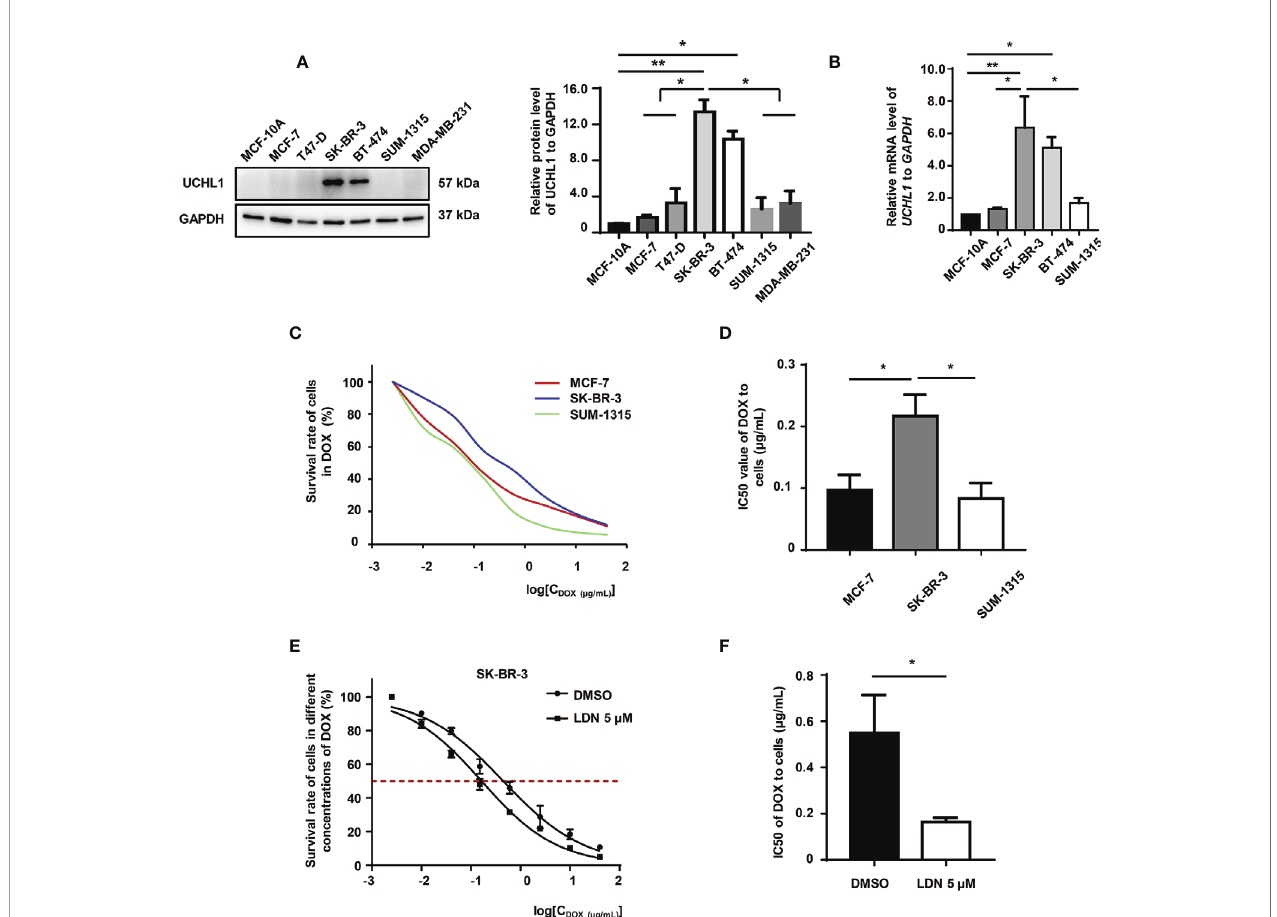
FIGURE 3 | UCHL1 level and its role in BC cells. Western blot (A) and real-time PCR (B) analysis of UCHL1 levels in BC cells are shown and were analyzed by Mann- Whitney test (n = 3). Cell viability curves of BC cells treated with DOX, as evaluated by CCK8 assay (C) . The IC50 values, as analyzed by Mann – Whitney test (n = 3) (D) . Cell viability curves and IC50 values of SK-BR-3 cells treated with DOX in the presence of 5 m M LDN or DMSO are shown (n = 3) (E, F) . * p < 0.05, ** p <